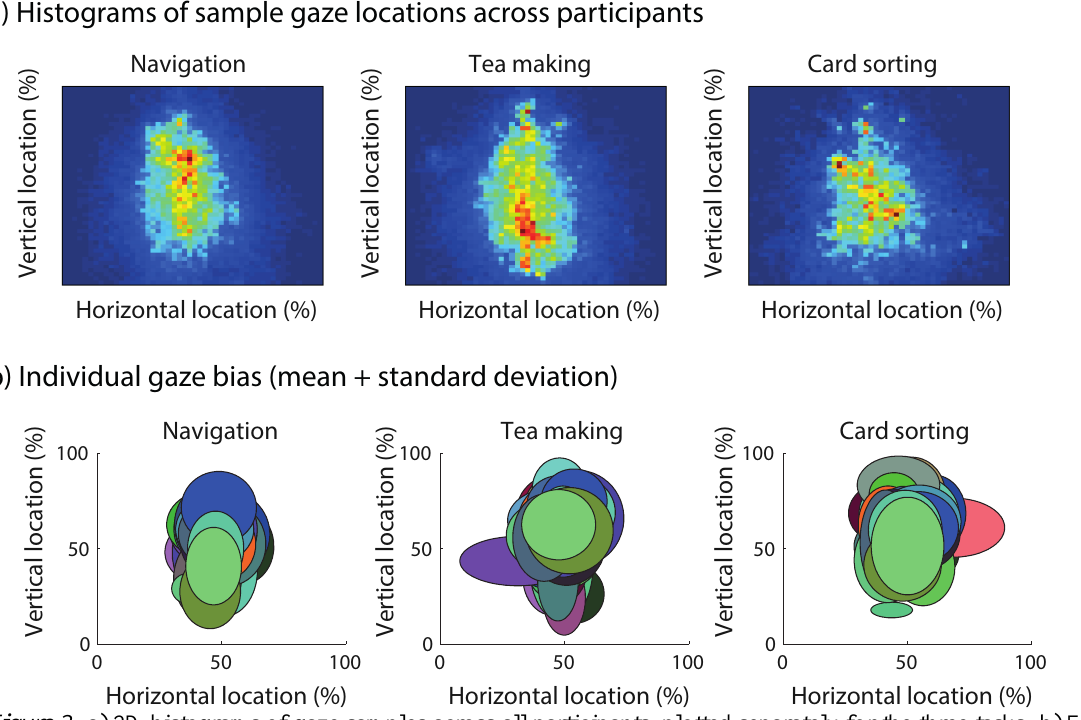
Figure 3 . a) 2D histograms of gaze samples across all participants, plotted separately for the three tasks. b) Ellipses showing the gaze bias for individual participants (ellipses showing one standard deviation away from the mean for each participant). Numbers along the horizontal and vertical axis indicate where in the head-centered video image the recorded gaze position was located. A number of, for example, 30% indicates that the recorded gaze was at a distance of 30% of the width of the image, measured from left of the image (horizontal axis) or at a distance of 30% of the height of the image, measured from the bottom of the image (vertical